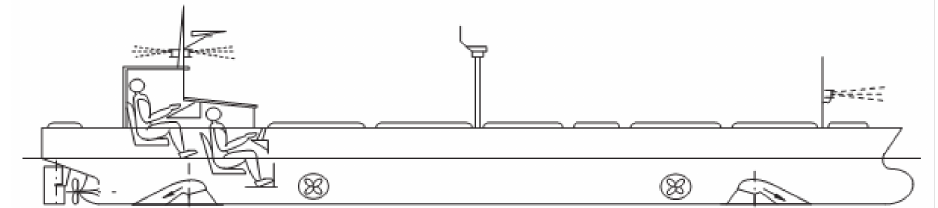
Figure 9. Training ship Blue